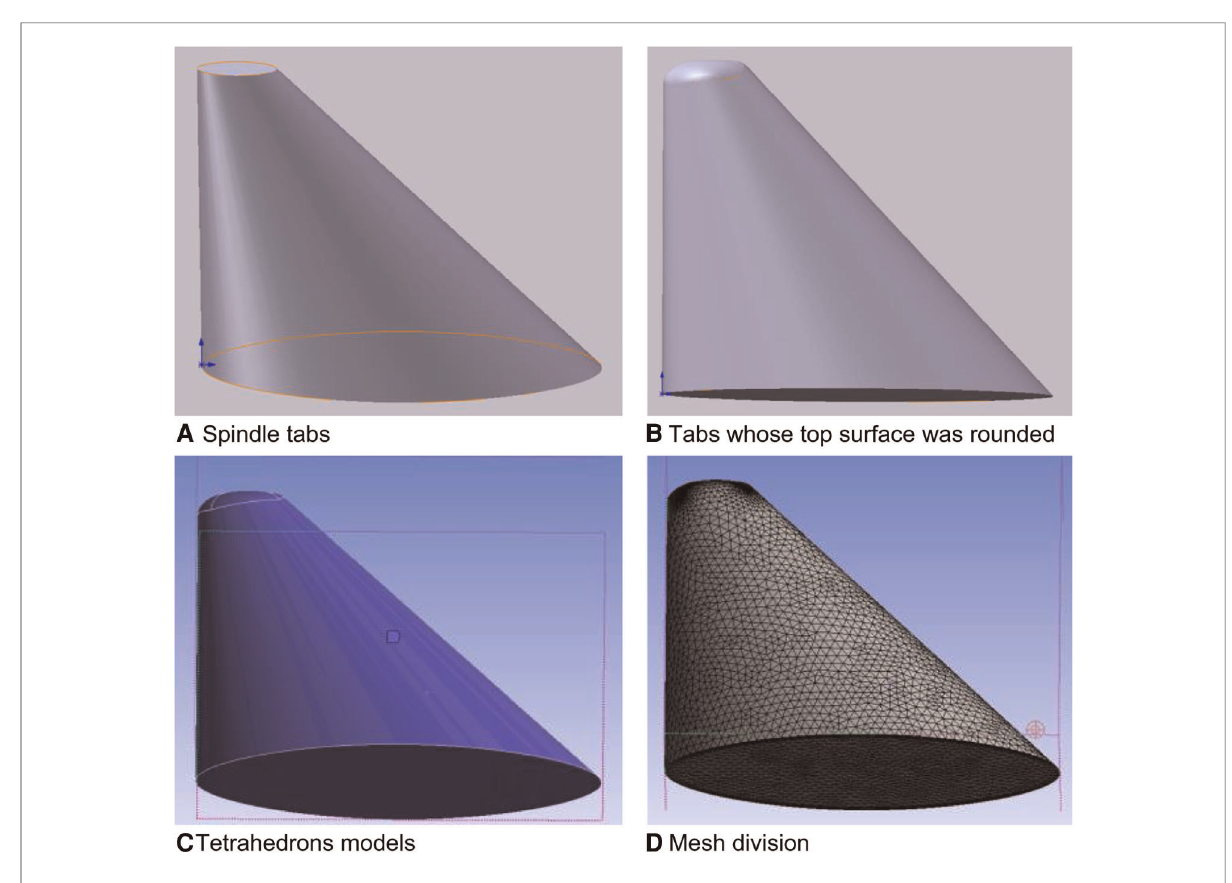
FIGURE 2 Schematic diagram of the straight incision model with spindle